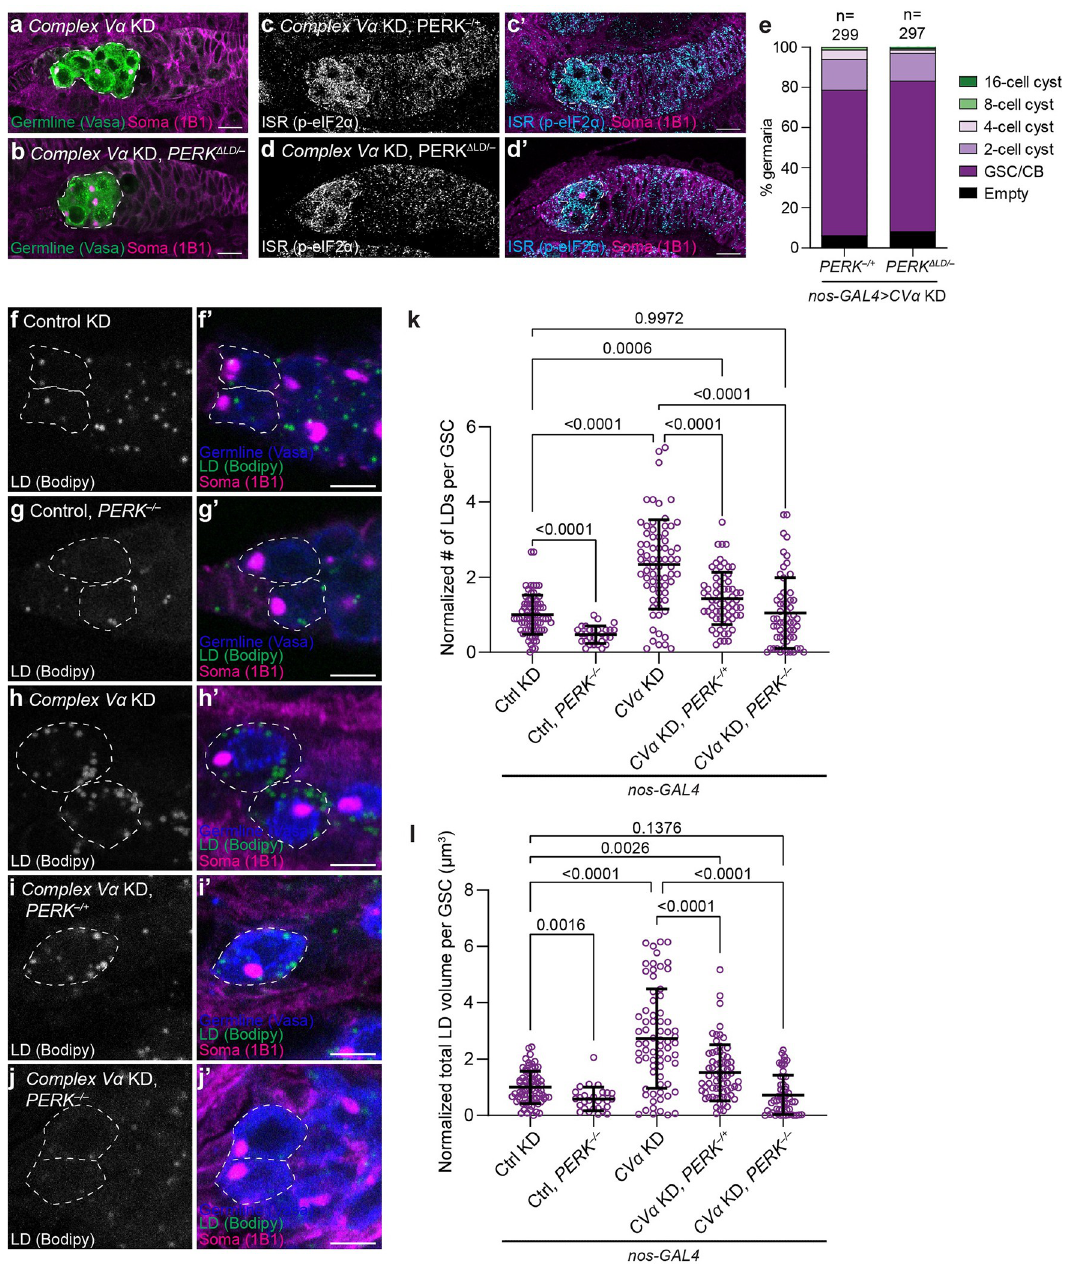
Fig 5. Complex V knockdown induces endoplasmic reticulum lipid bilayer stress. (a-d) Representative images of 1-day old CV α KD, PERK –/+ (a, c) and CV α KD, PERK Δ LD/– (b, d) germaria. GSCs are outlined in white-dashed lines. (e) Quantification of germline differentiation stage in germaria of indicated genotypes. Number of germaria scored above each bar. (f-j) Representative images of 2–3 day old Control ( mCherry) KD (f) , PERK –/– (g) , CV α KD (h) , CV α KD, PERK –/+ (i) and CV α KD, PERK –/– (j) GSCs (white- dashed line). BODIPY 493/503 marks lipid droplets. (k) Quantification of number of lipid droplets per GSC normalized to mean of Control for the indicated genotypes ( n = 75 for Ctrl ( mCherry ) KD; n = 28 for Ctrl, PERK –/– ; n = 71 for CV α KD; n = 68 for CV α KD, PERK –/+ ; and n = 59 for CV α KD, PERK –/– ). (l) Quantification of total lipid droplet volume per GSC normalized to the mean of the Control for the indicated genotypes ( n = 73 for Ctrl ( mCherry ) KD; n = 28 for Ctrl, PERK –/– ; n = 72 for CV α KD; n = 68 for CV α KD, PERK –/+ ; and n = 55 for CV α KD, PERK –/– ). All RNAis were driven by nos-GAL4 . Scale bars represent 10 μ m (a-d) and 5 μ m (f-j) . For all plots, germaria were studied from 10 or more ovaries, obtained in at least three independent experiments and over two or more crosses. For (k, l) , data are mean ± s.d. and one-way ANOVA followed by Games-Howell multiple comparison’s test was used for statistical analysis. For exact genotypes see S2 Table.